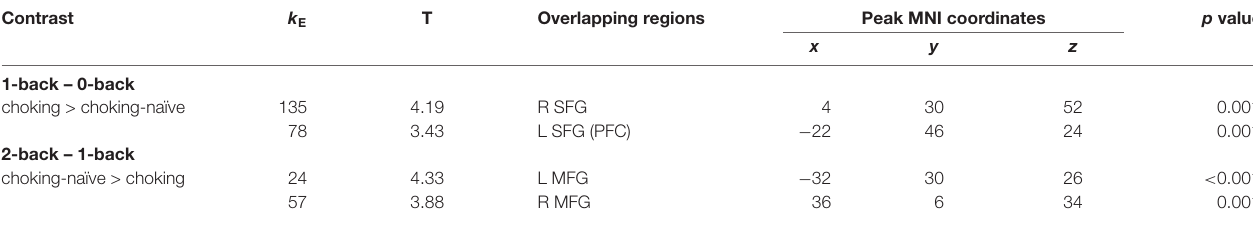
TABLE 3 | Activation details for significant activation clusters for group comparisons on visual N-back working memory task. Contrast k E T Overlapping regions Peak MNI coordinates p value